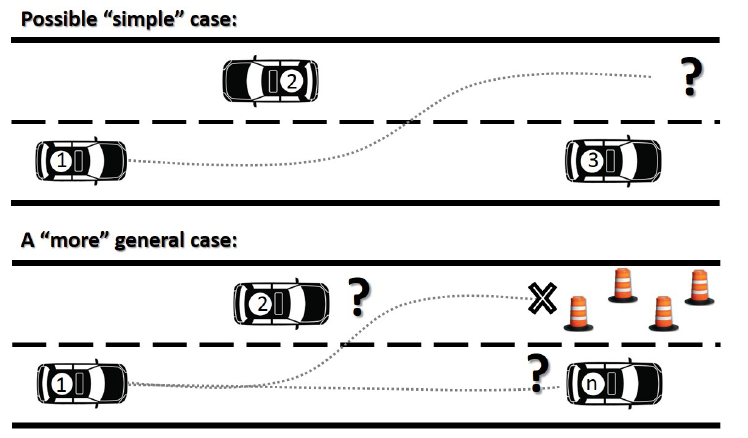
Figure 1. Trajectory planning problem under traffic